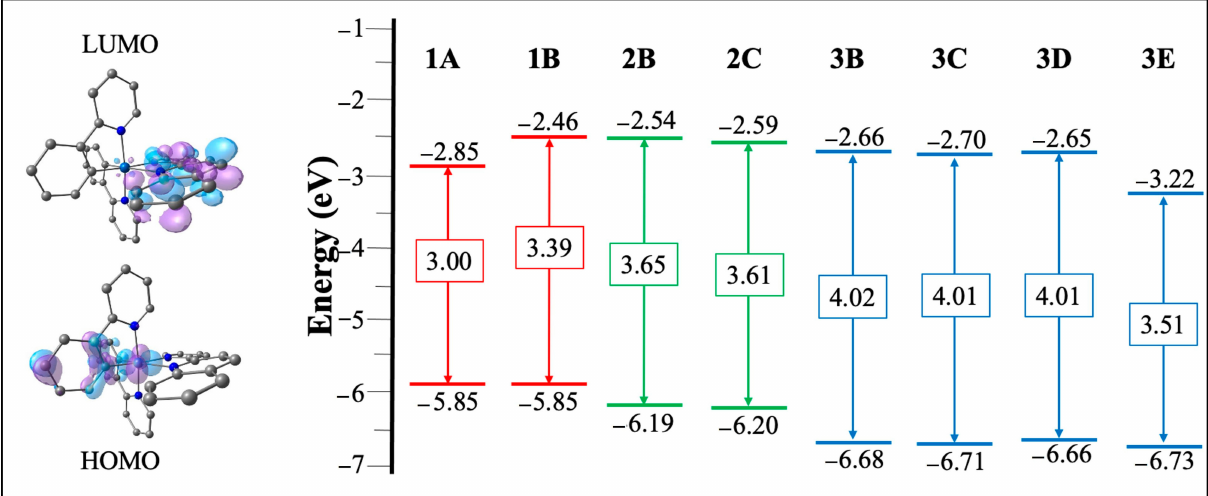
Figure 2. Molecular orbitals diagram for all complexes and HOMO–LUMO plots for 1A as represen- tative of all complexes (for the rest of the complexes, see Figures